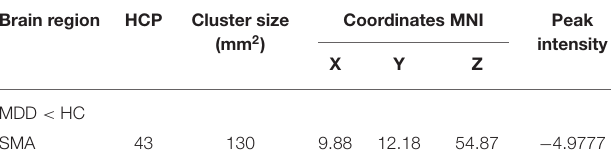
TABLE 2 | The demographic and clinical data between responders group and non-responder group at baseline and 2 weeks. Variable